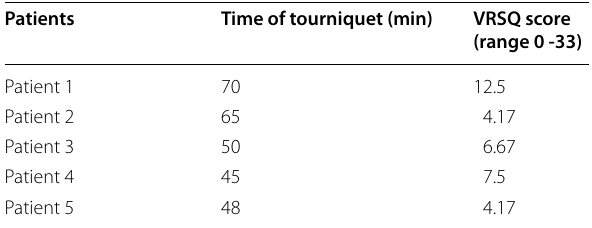
Table 4 The time of tourniquet and VRSQ score